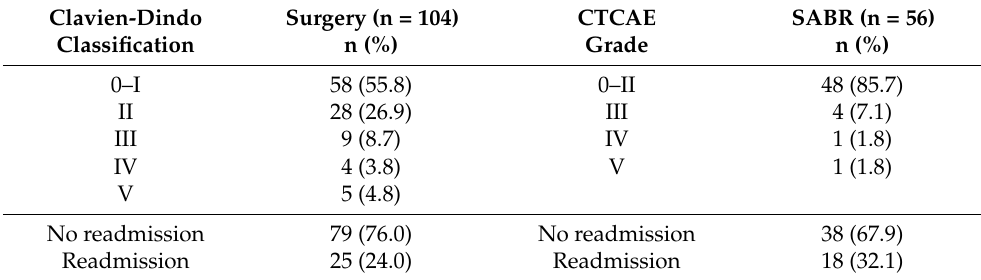
Table 3. Type of treatment intolerance, stratified for type of treatment. Clavien-Dindo Classification